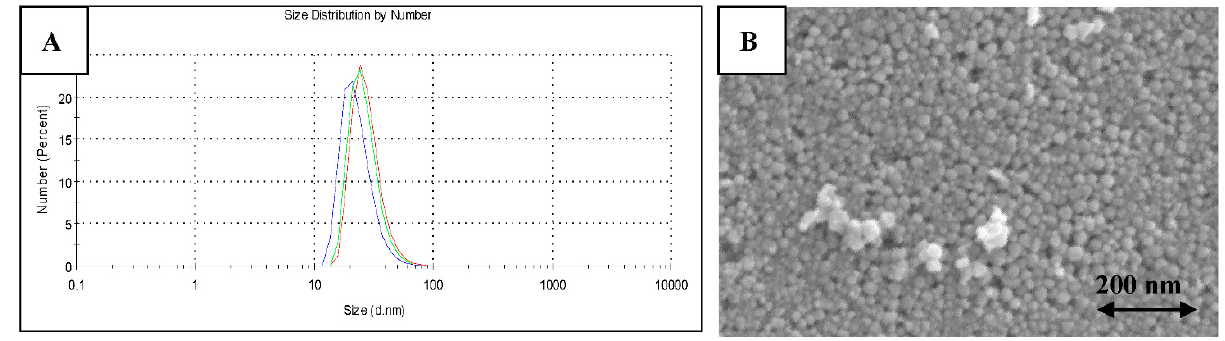
Figure 2. The size distribution ( A ), as the value of three subsequent runs of the instrument, and SEM image ( B ) of Ag NPs.